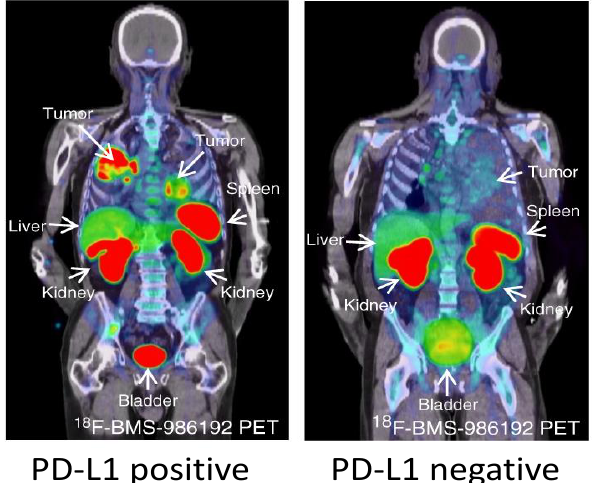
Figure 3. 18 F-BMS-986192 tumor uptake in patients. Patient 2 with tumor with PD-L1 expression > 95% (left panel). 18 F-BMS-986192 PET (145.7 MBq, imaging time point 1 h post injection (p.i.)) demonstrates heterogeneous tracer uptake within and between tumors. Patient 3 with tumor PD-L1 expression < 1% (right panel). 18 F-BMS-986192 PET (214.62 MBq, 1 h p.i.) demonstrates low tumor tracer uptake. Physiological expression = driven uptake in the spleen and non-specific uptake in the liver were observed with 18 F-BMS-986192. Red and blue in the images represent maximum and minimum accumulated radioactivity, respectively, if a rainbow color scale is used(from